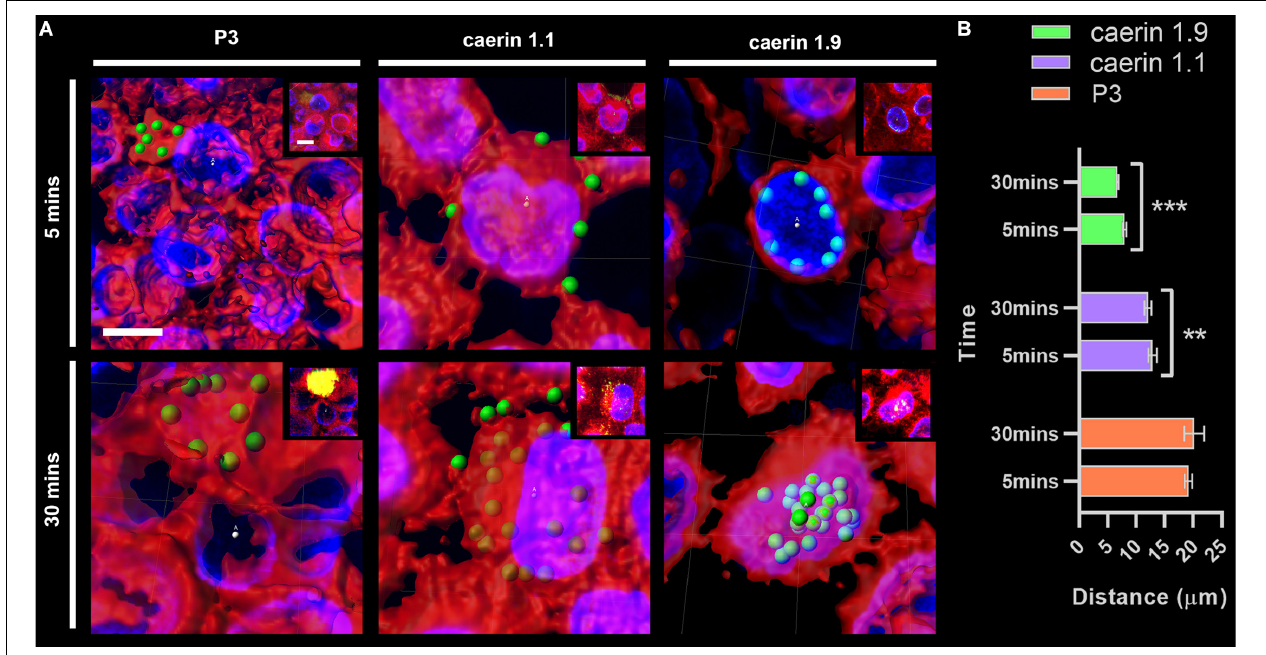
FIGURE 3 | The distance between fluorescent signals and cell center points. The distance between P3, caerin 1.1 and 1.9 conjugated fluorescent signals with the cell center points was measured. (A) The distance between conjugated fluorescent signals with cell center points after treated by P3, caerin 1.1 and 1.9 for 5 min and 30 min. (B) The histogram shows the distance between the conjugated fluorescent signals with cell center points. Data are shown as mean ± SEM. *** P < 0.001, ** P < 0.01, one-way ANOVA, Sidak’s multiple comparisons test. Scale bar, 10 µ m. The images were captured by Confocal Laser Scanning Microscope (Olympus FLUOVIEW). The data three-dimensional reconstruction was generated by Imaris